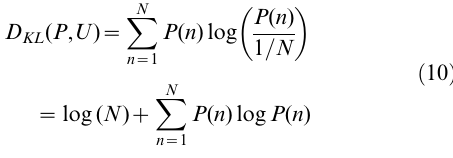
Extract the phase signals from x phase signals from x Amplitude j